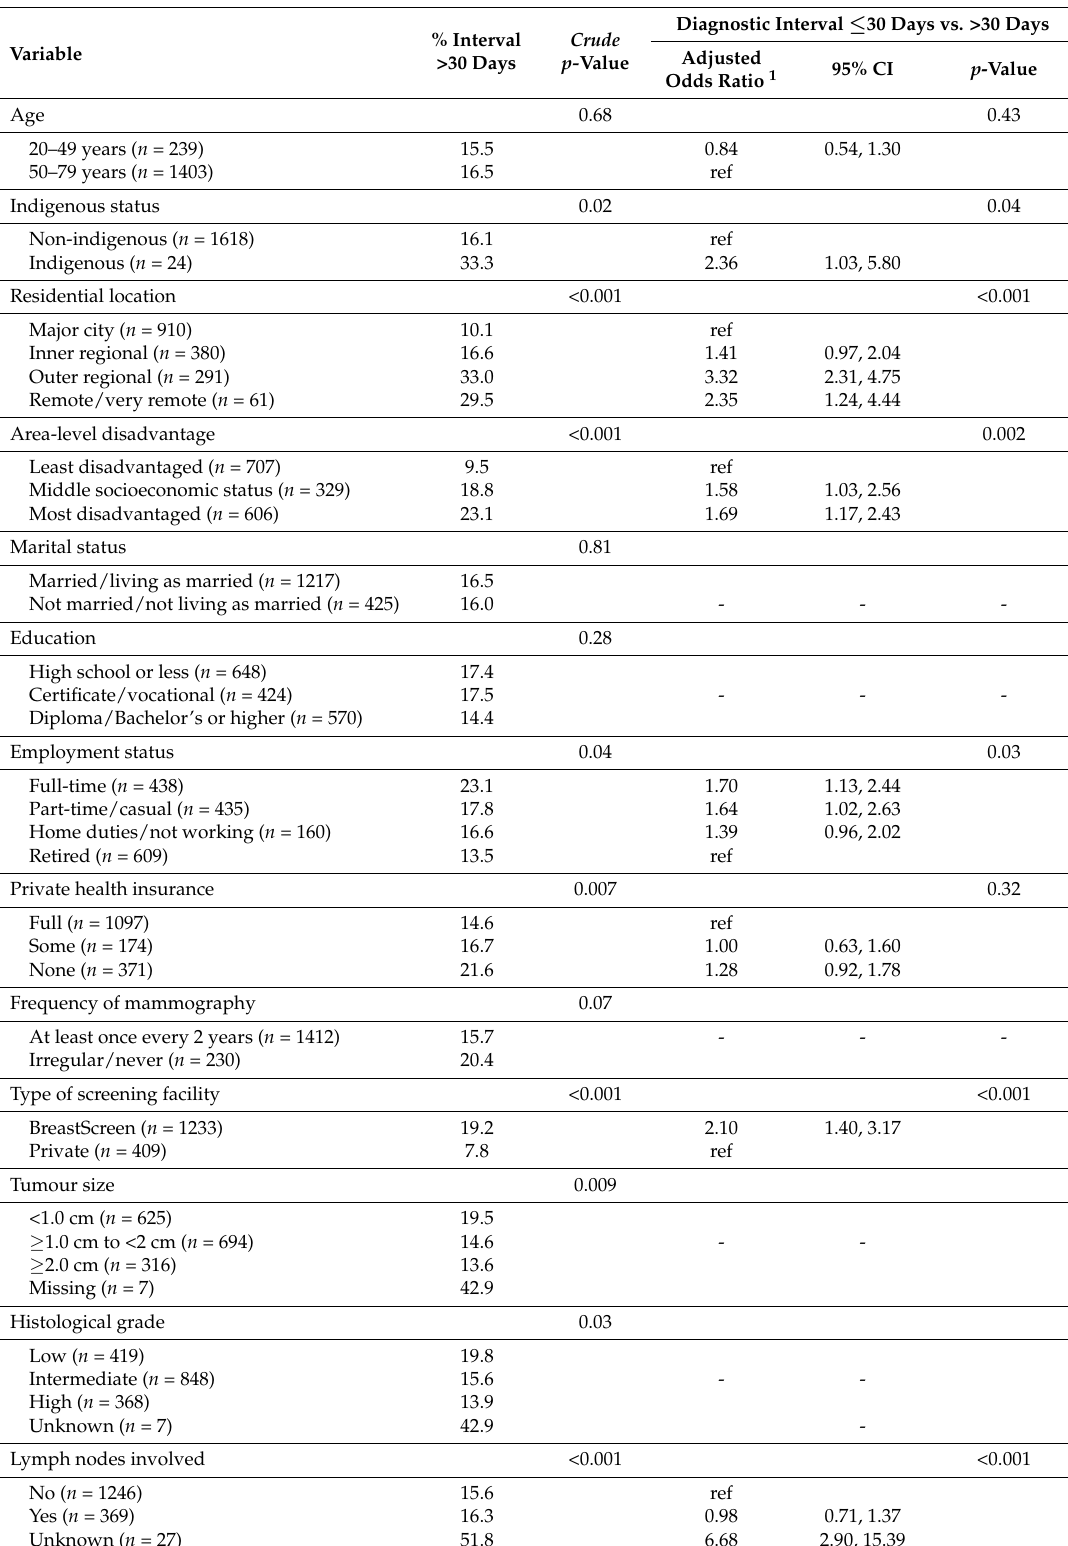
Table 5. Relationship between diagnostic delay and sociodemographic and clinical variables amongst 1642 women in Queensland, Australia with screen-detected breast